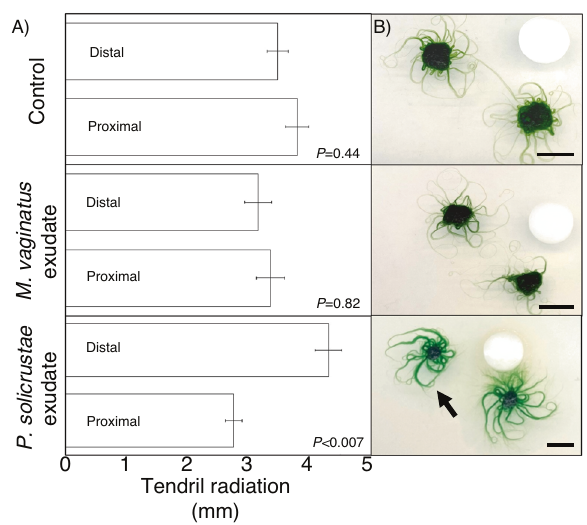
Fig. 3 Chemotactic response of M. vaginatus PCC9802 to cyanobacterial exudates. A Average tendril radiation toward (proximal) or away (distal) stimulus source ( n = 5). B Representative photographs of the chemotactic behavior of M. vaginatus . Control consists of BG11 medium containing no exudates. Black arrow indicates M. vaginatus tendrils sweeping away from cellulose disk soaked in P. solicrustae spent growth medium. Scale bar is 5 mm. Given that the original data were normally distributed, signi fi cance of the comparisons is based on t test.